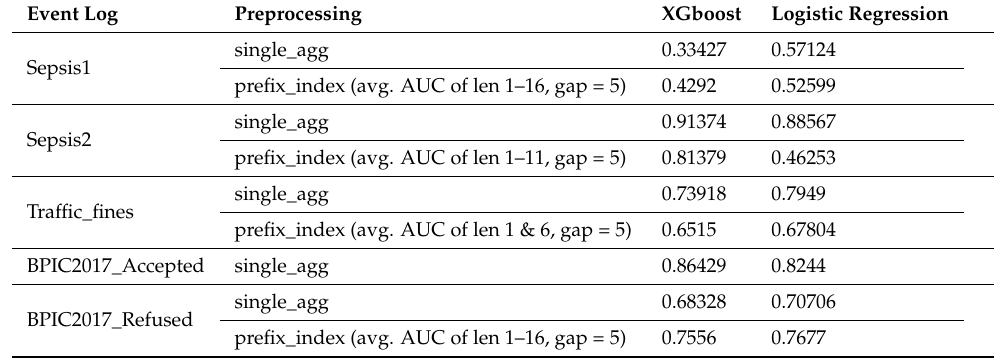
Table 7. AUC scores of predictive models categorized according to preprocessing